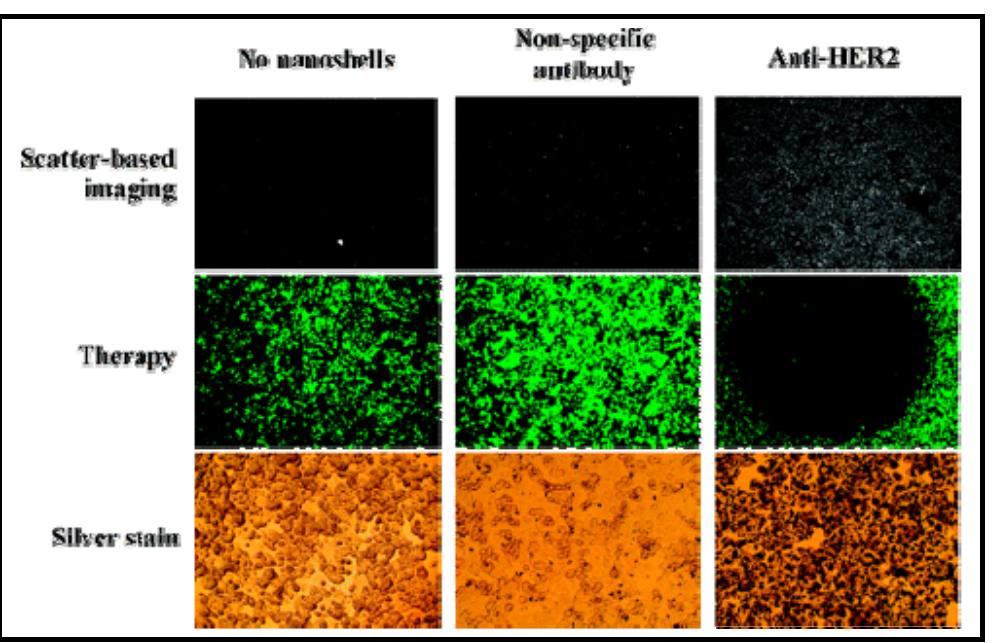
Figure 8. Use of gold nanoshells (GNSs) for PTT. Combined imaging and therapy of breast cancer cells using HER2-targeted GNSs. Scatter-based darkfield imaging of HER2 expression (top row), cell viability was tested via calcein staining (middle row), and silver stain assessment of GNS binding (bottom row). Reproduced with permission